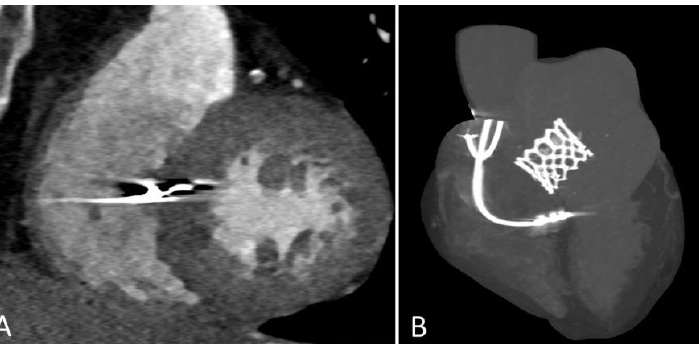
Figure 2. Computed tomography (CT) images of a patient with AV block after transcatheter aortic valve replacement and consecutive dual-chamber PM implantation with a ventricular lead in LBBAP position. ( A ) The deep septal implantation site of the CSP lead in a short-axis projection. ( B ) The basal implantation site in the proximal left bundle in a reconstruction. The resulting ECG is shown in Figure 1.